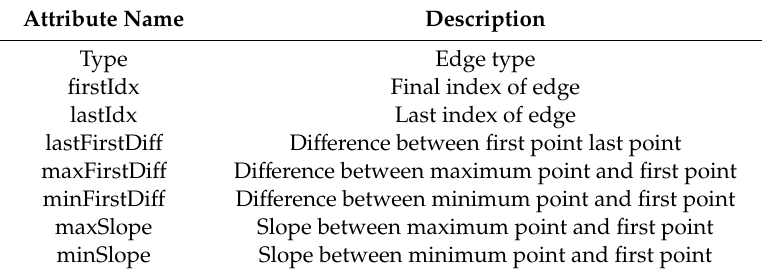
Figure 7. Illustration of edges and a few edge attributes. Table 3. List of edge attributes.